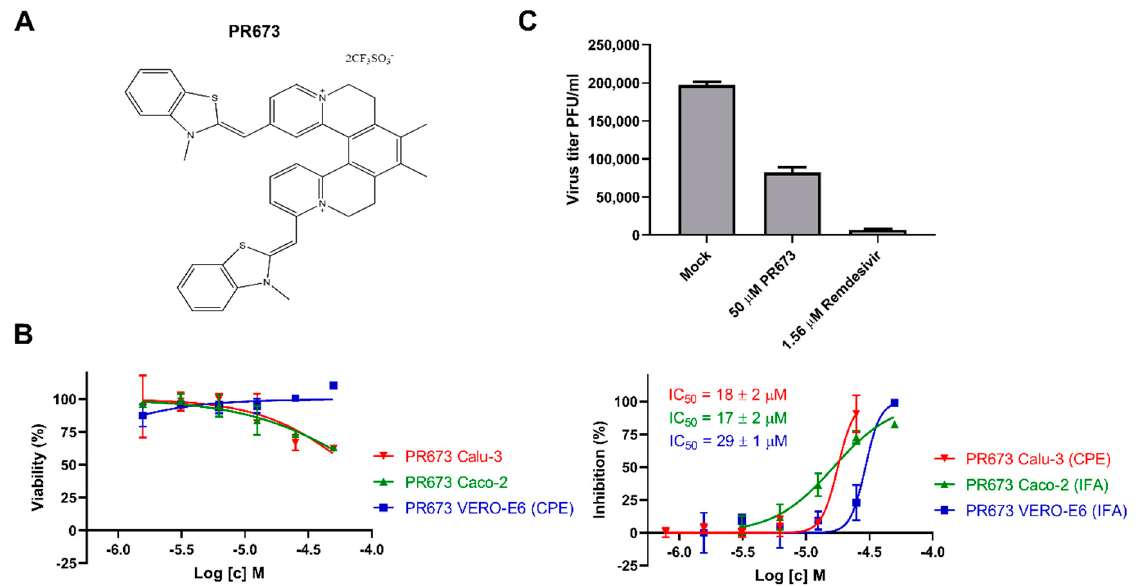
Figure 1. Inhibitory activity of PR673 against SARS-CoV-2. ( A ) The chemical structure of PR673. ( B ) Left panels: dependence of viability of VERO-E6, Calu-3 and Caco-2 cells on PR673 concentration; right panels: dependence of inhibition of SARS-CoV-2 in VERO-E6, Calu-3 and Caco-2 cells on PR673 concentration. ( C ) Comparison of PR673 and remdesivir in SARS-CoV-2 yield reduction assay. The VERO-E6 cells were incubated with PR673, remdesivir and a mock followed by SARS-CoV-2 infection at MOI 0.04 for 3 days, and the virus yield was determined by plaque assay in VERO-E6 cells.